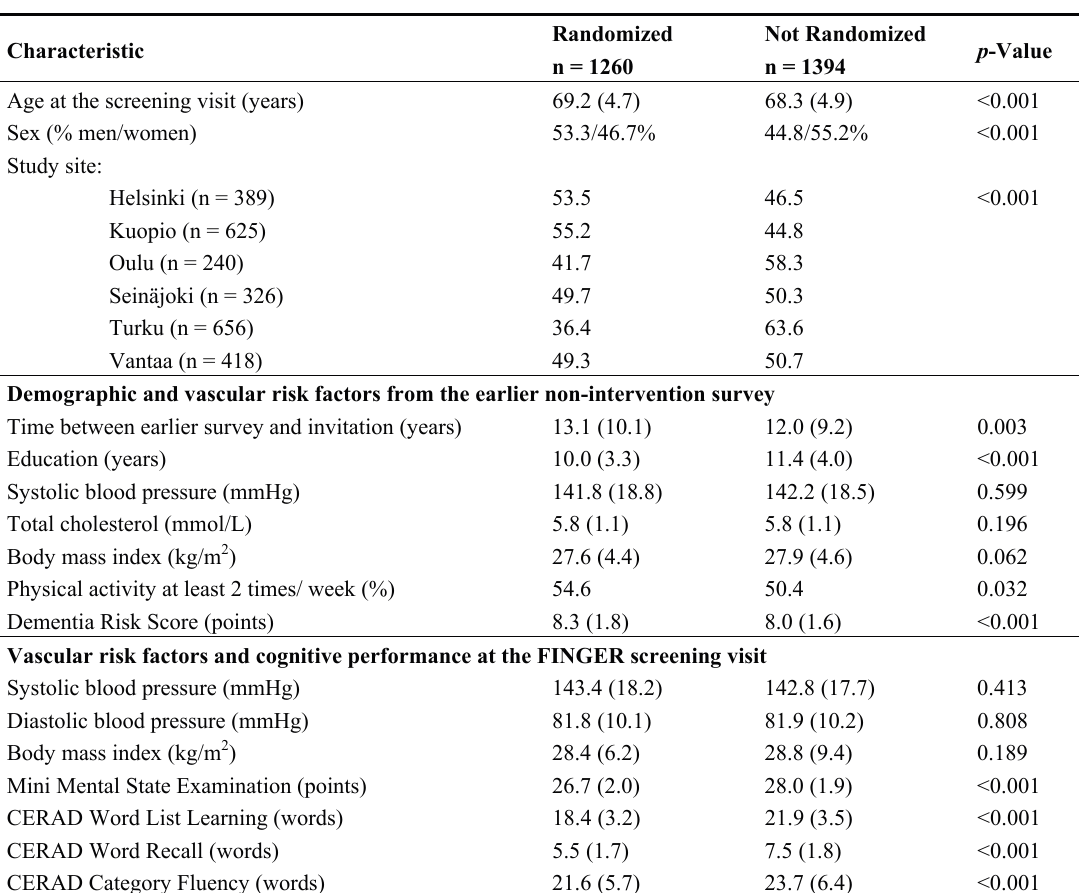
Table 2. Characteristics of the persons who attended the screening visit according to eligibility to the trial (mean (SD) or